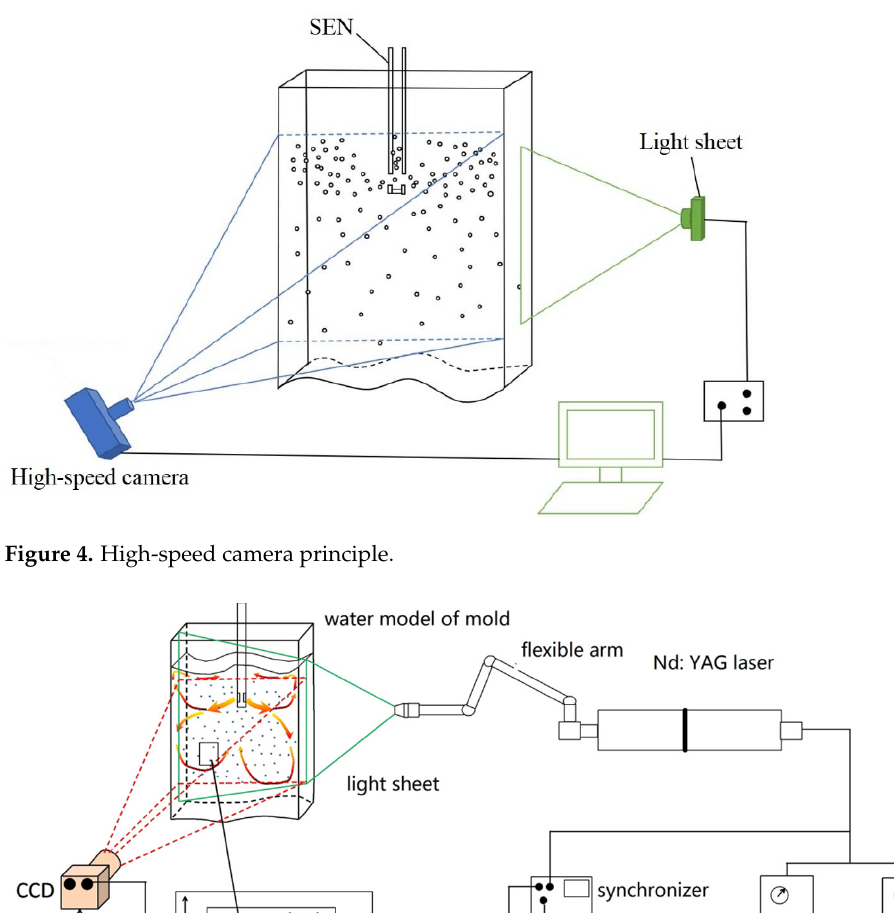
Figure 6. The influence of oil added to the liquid level on the flow field in the mold: ( a ) no oil; ( b ) oil thickness 3 mm. Figure 7 shows the comparison of the surface horizontal velocity before and after adding the oil phase. Without adding silicone oil, the maximum horizontal velocity of the liquid level on the left side of the water outlet is 0.091 m·s − 1 , and the velocity is still 0.02 m·s − 1 even near the outer wall of the water outlet. After adding silicone oil, at 85 mm from the nozzle, the maximum horizontal velocity on the left side of the outlet is reduced to 0.065 m·s − 1 , the level velocity decreases to a very weak level. The right side of SEN is the same as the left side: without adding silicone oil, the velocity of the liquid level is 0.093 m·s − 1 . At the position near the outer wall of the nozzle, the liquid level velocity is still 0.02